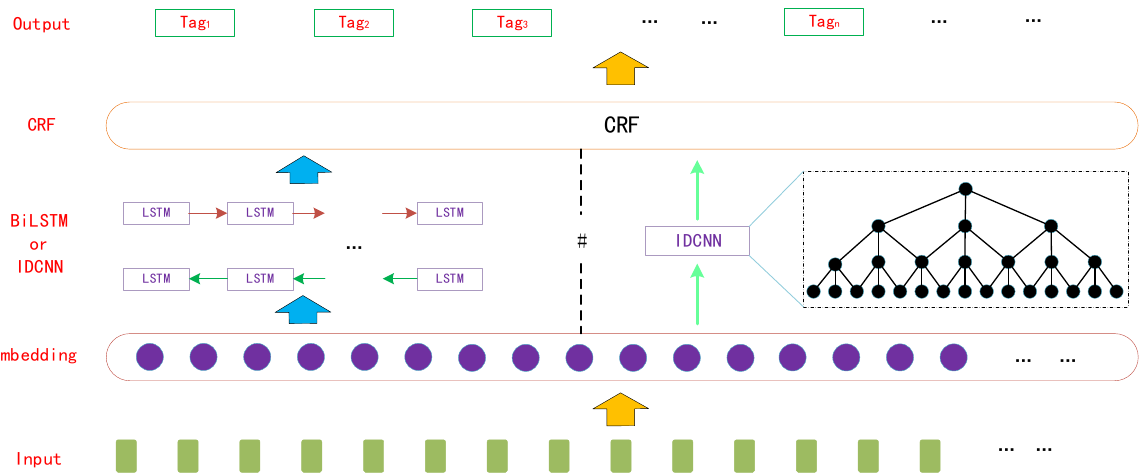
Figure 2. The network structure of the model, where “#” is the separator, the left side of “#” is the BiLSTM-CRF model, and the right side of “#” is the IDCNN-CRF model.